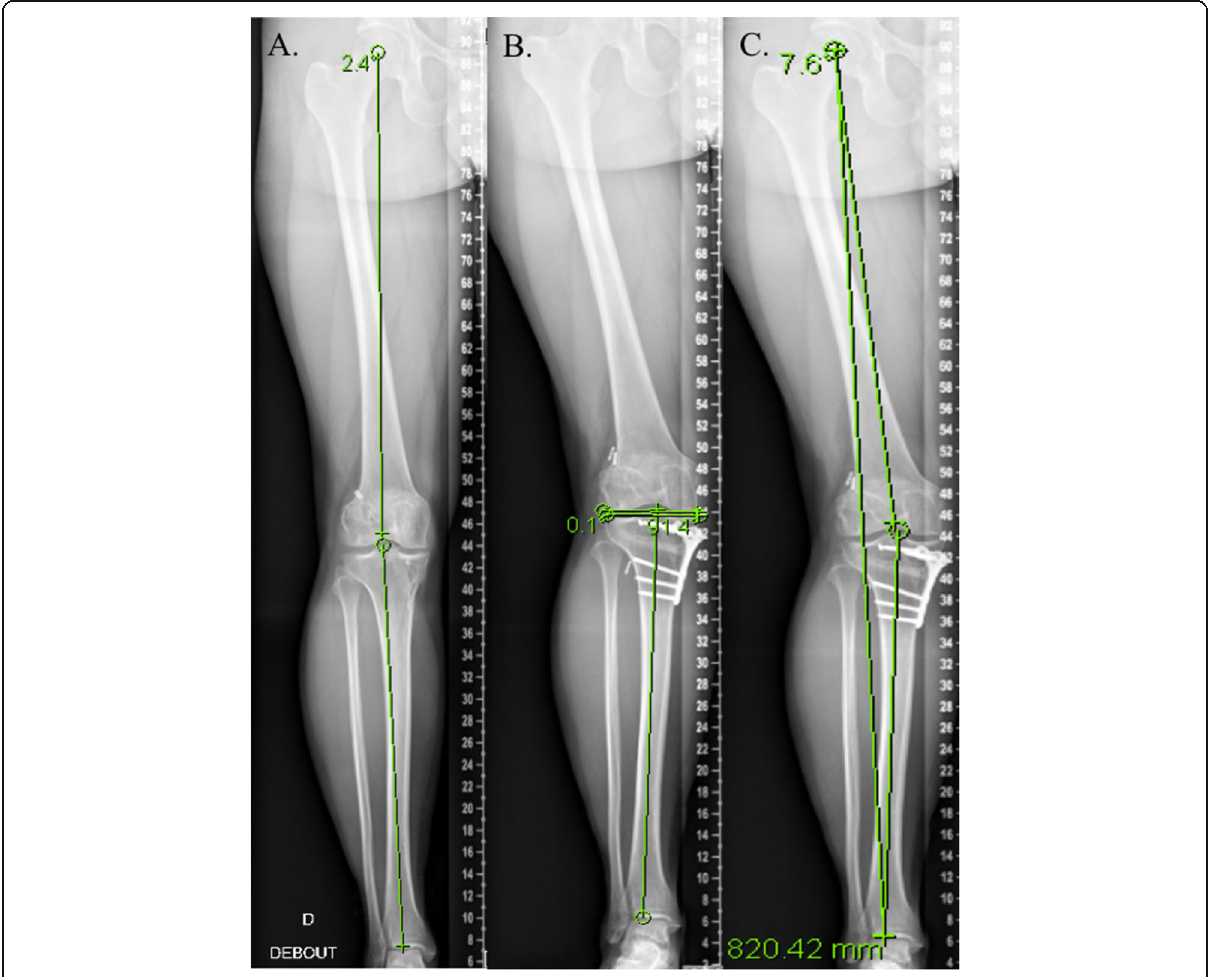
Fig. 2 Overcorrection after open-wedge high tibial osteotomy performed without considering the JLCA. a . Patient complain medial pain due to previous history of meniscectomy, the preoperative global alignment is 3° varus, Medial proximal tibial angle (MPTA) = 86° and Joint line convergence angle (JLCA) = 5°, b . an intended correction of 6° is performed with a postoperative MPTA = 92° but C. the patient had a postoperative overcorrection of 7° valgus with a JLCA =